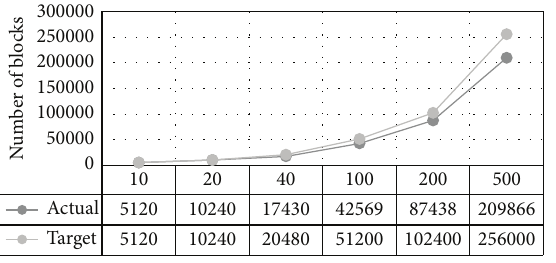
Figure 17: Error rate caused by the database server in case of larger number of